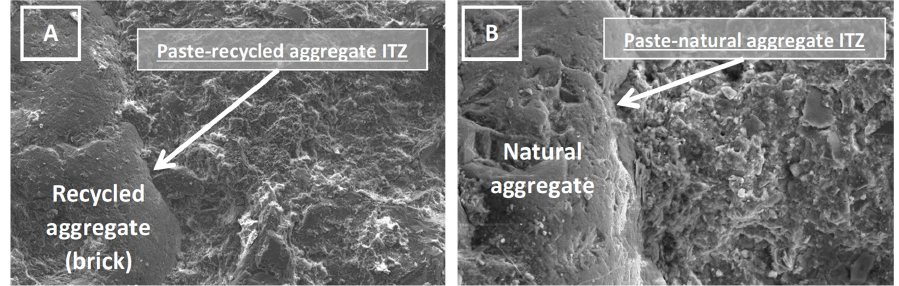
Figure 7. ( A ) Scanning electron microscope image of recycled concrete. ( B ) Scanning electron microscope image of conventional concrete.